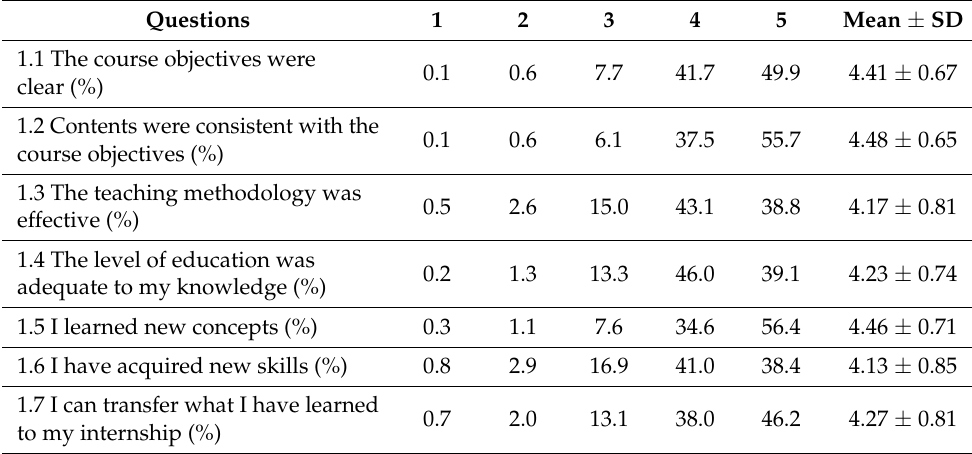
Table 4. Results of satisfaction